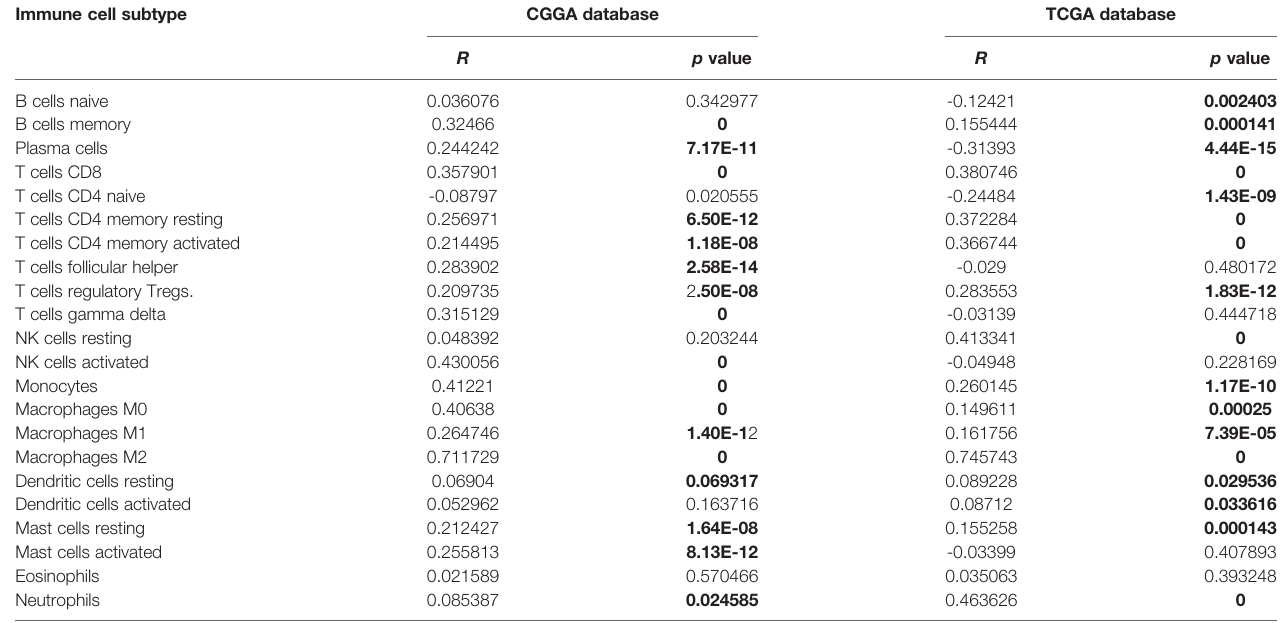
TABLE 2 | Correlation between MD2 and immune cell subtype in glioma. Immune cell